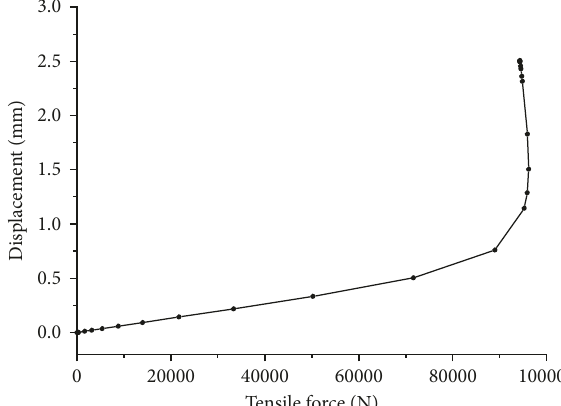
Figure 18: Wedge slices at different positions: (a) c (b) c 68 ° , (c) c (cid:30) c 78 ° , (h) c (cid:30) c 88 ° . (cid:30)